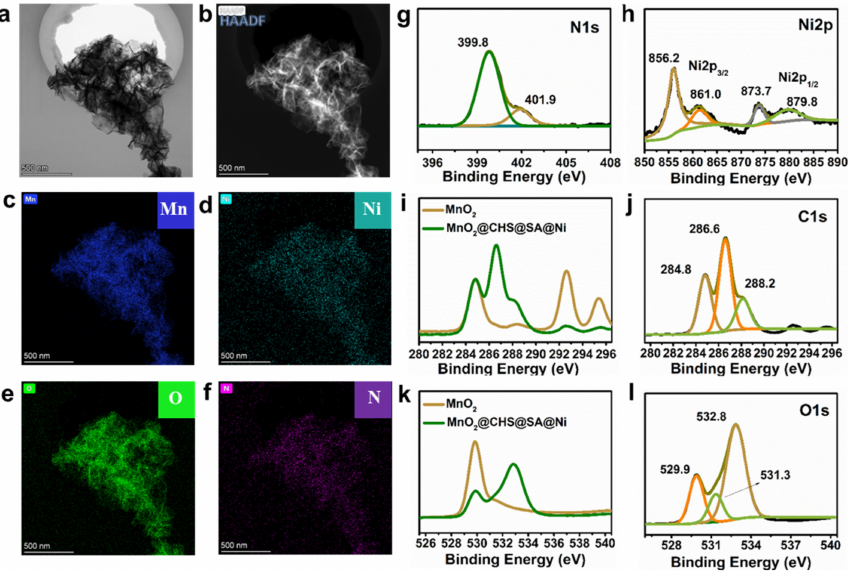
Figure 2. Structural analysis of MnO 2 @CHS@SA@Ni hybrids using TEM and XPS techniques. ( a ) TEM image, ( b ) HAADF image, ( c – f ) elemental mapping (Mn, Ni, O and N, scale